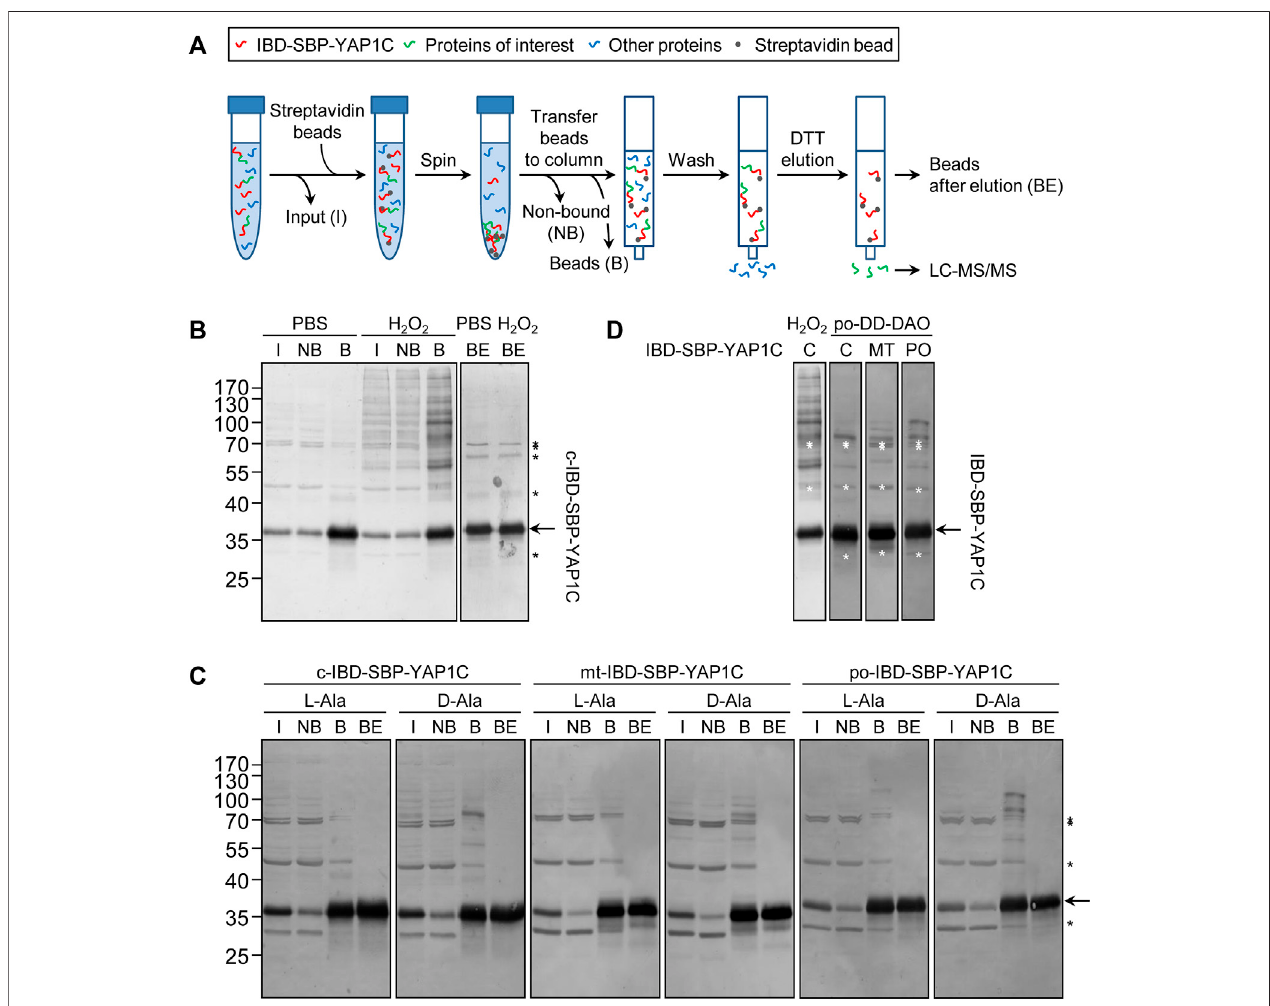
FIGURE 2 | The interaction pro fi les of IBD-SBP-YAP1C with sulfenylated proteins differ considerably depending on the source of H 2 O 2 as well as its subcellular location. (A) Outline of the experimental work fl ow (for a detailed explanation, see Materials and Methods section). I, input; NB, non-bound proteins; B, bound IBD-SBP- YAP1C complexes; BE, beads after elution. (B) C-IBD-SBP-YAP1C complex formation upon external H 2 O 2 treatment. Flp-In T-REx 293 cells expressing c-IBD-SBP- YAP1C were incubated in DPBS containing 10 mM 3-AT and supplemented or not with 1 mM H 2 O 2 . After 10 min, free thiol groups were blocked with NEM, and thesampleswereprocessedasdepictedinpanelAand subsequently subjectedtoimmunoblottingwithrabbit pre-immuneserum (seeMaterialsandMethodssection). (C) Peroxisomal H 2 O 2 production triggers IBD-SBP-YAP1C complex formation in the cytosol, mitochondria, and peroxisomes. After induction and chase, po-DD-DAO Flp-In T-REx 293 cells expressing c-, mt-, or po-IBD-SBP-YAP1C were incubated in DPBS containing 10 mM 3-AT and supplemented with either 10 mM L- or D-Ala. After 10 min, the cells were processed as detailed in the legend of panel (B) . (D) Comparison of IBD-SBP-YAP1C complexes formed under different experimental conditions. In the two left lanes, the staining patterns of c-IBD-SBP-YAP1C formed upon external H 2 O 2 addition or peroxisomal H 2 O 2 production are compared; in the three right lanes, differentially located IBD-SBP-YAP1C complexes formed upon peroxisomal H 2 O 2 production are compared. The different lanes are the aligned bound samples of those shown in panels (B) and (C) . The arrows and asterisks mark IBD-SBP-YAP1C and non-speci fi c immunoreactive bands, respectively.